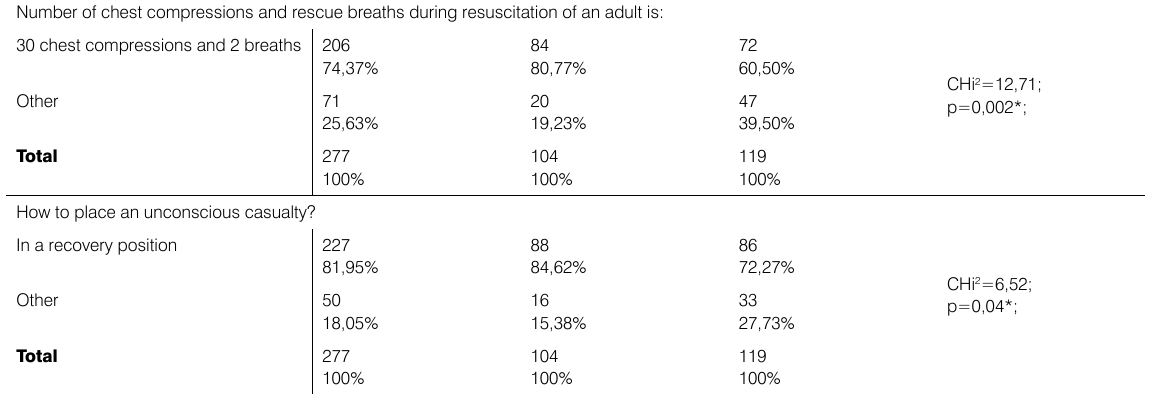
Table 1. Assessment of First Aid classes among secondary school students and its correlation with their knowledge - Number of chest compressions and rescue breaths during resuscitation of an adult is: